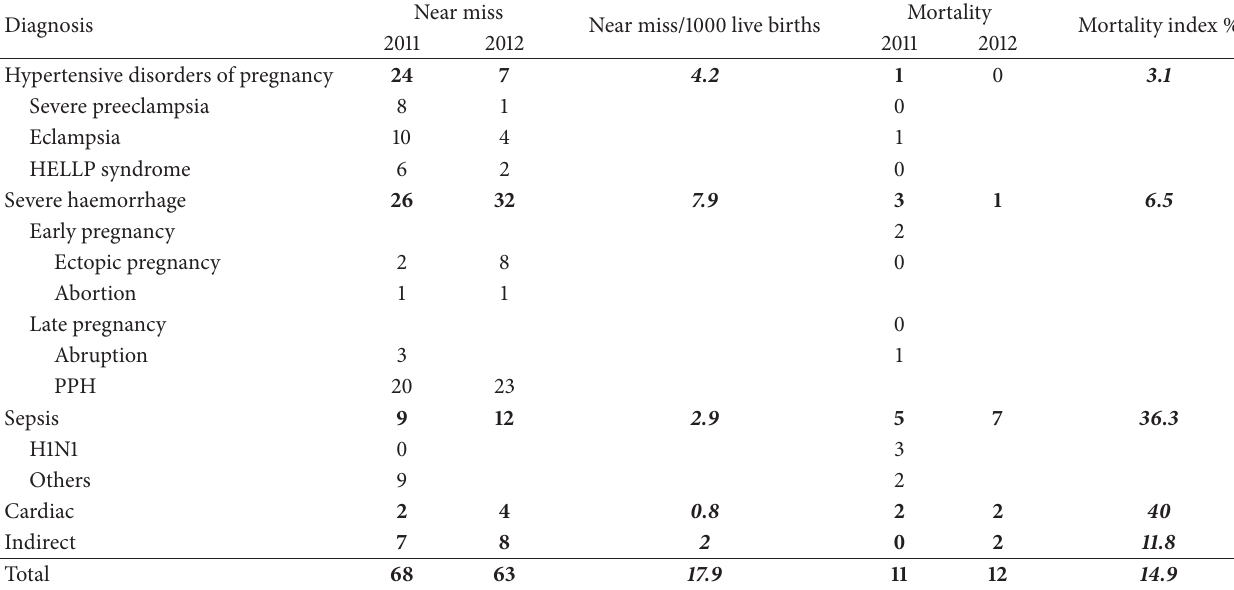
Table 2: Comparison of near miss events and primary causes of maternal